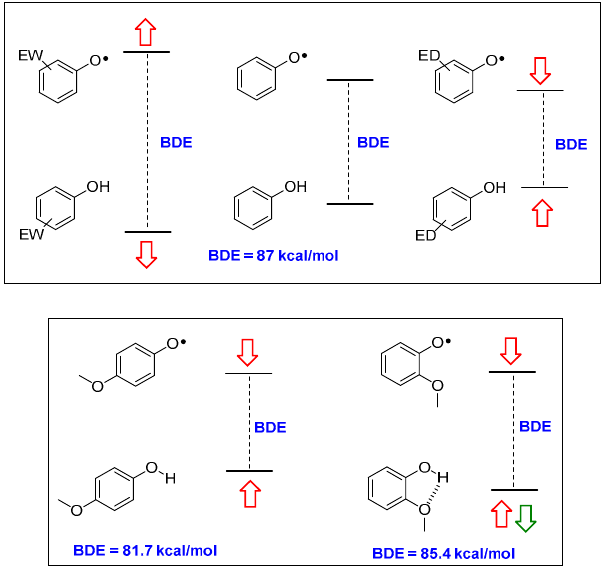
Figure 2. Electronic (red arrows) and intra-HB (green arrows) effects in modifying the ArO-H BDE value in substituted phenols. ED—electron-donating; EW—electron-withdrawing; BDE—Bond Dissociation Enthalpy.